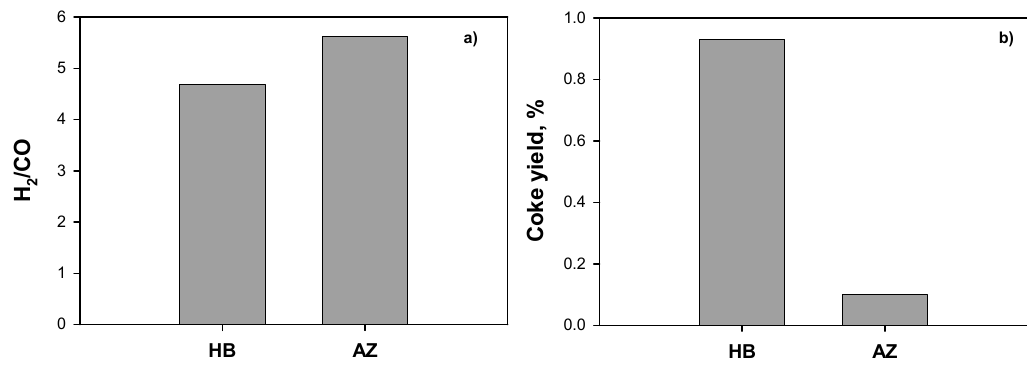
Figure 9. ( a ) H 2 / CO ratio for the HB and AZ solvents mixtures during steam reforming on 5 Ni at 720 ◦ C and atmospheric pressure; gas-phase feed composition: Solvent / H 2 O / O 2 / N 2 = 0.7 / 6 / 0.8 / 92.5. ( b ) Coke yields for HB and AZ solvents mixture.